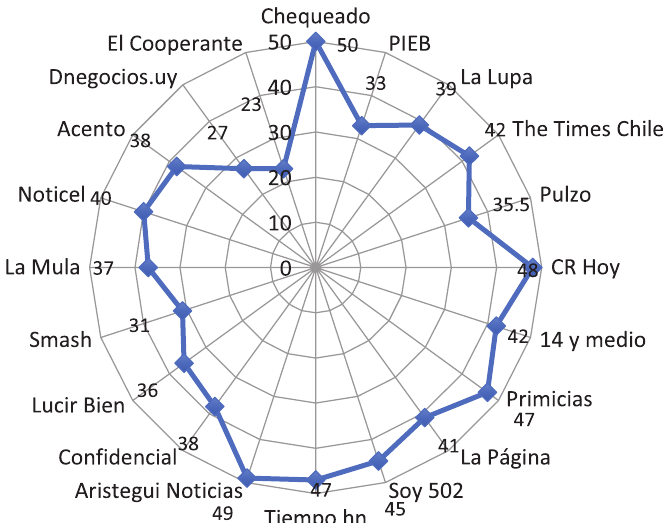
Figure 2. Global scoring of Latin America’s digital native